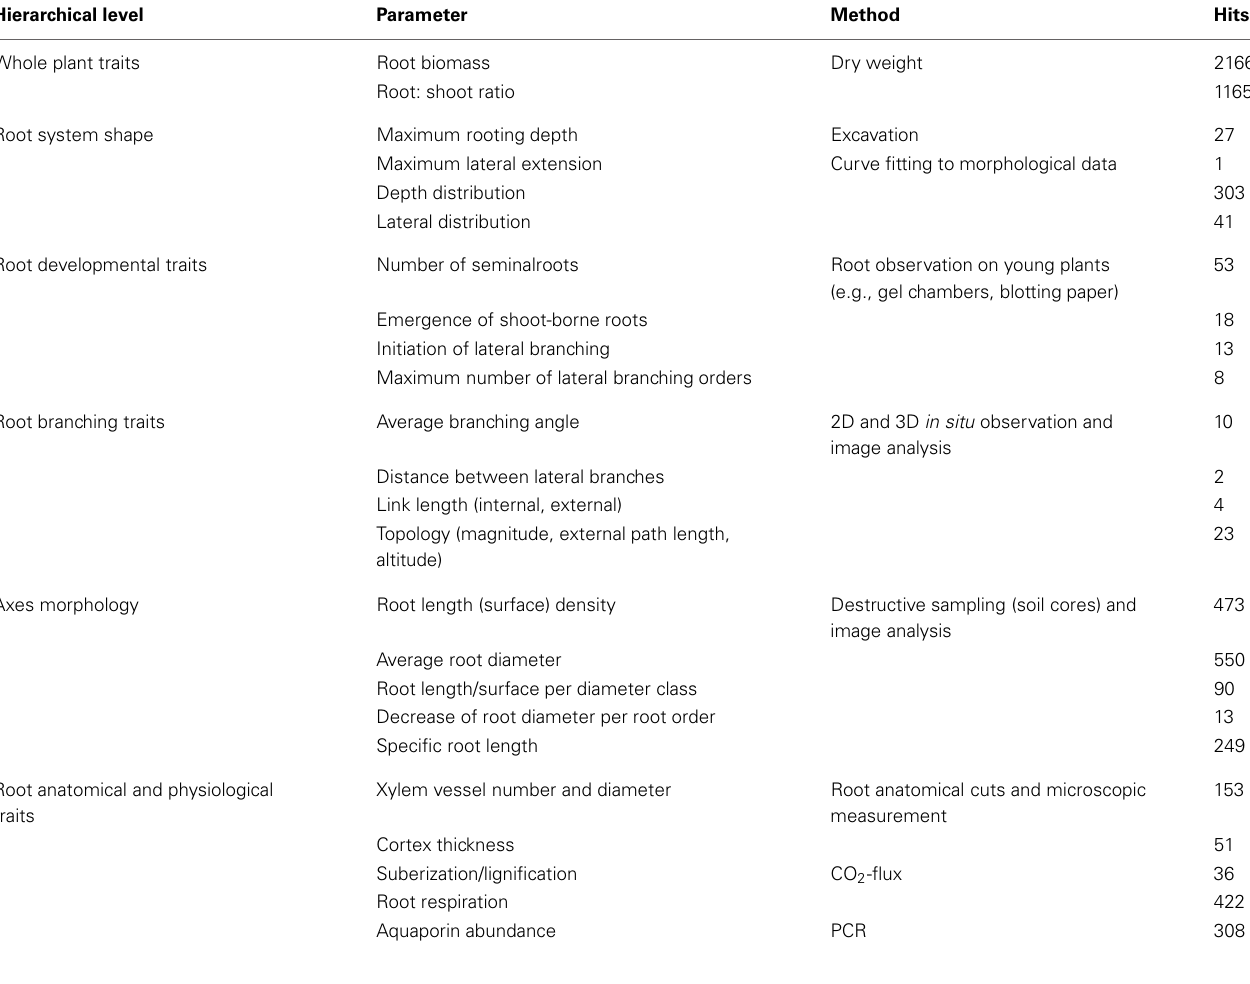
Table 2 | Traits at different observation scales for a comprehensive, hierarchically ordered core data set to classify root systems, common measurement methods, and Scopus database hits from keyword